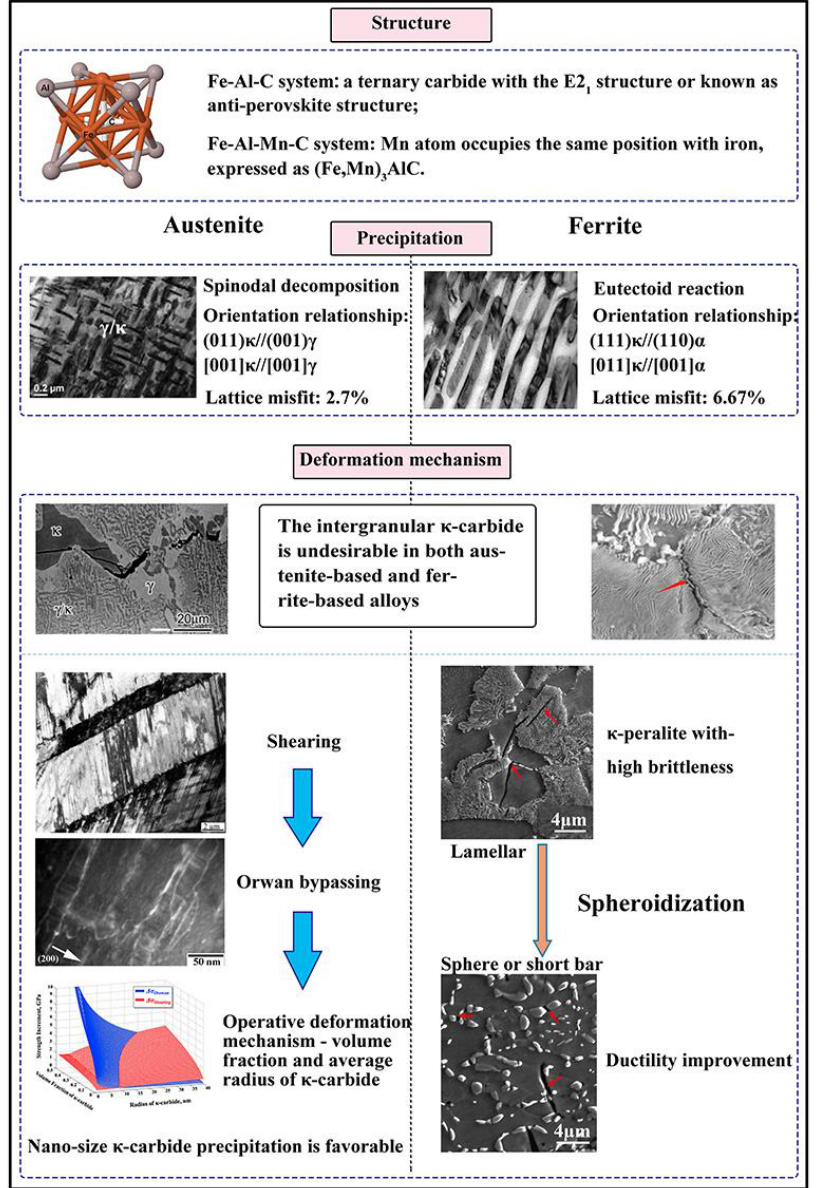
Figure 11. Overall view of the precipitation and deformation of κ -carbide in Fe-Mn-Al-C steels. (Adapted with permission from [2], copyright Elsevier, 2004; [3] Wiley, 2016; [10] Taylor and Francis, 2004; [15] Taylor and Francis, 2015; [21] Elsevier, 2008; [65] Elsevier, 2019 and [20] Elsevier, 2019).